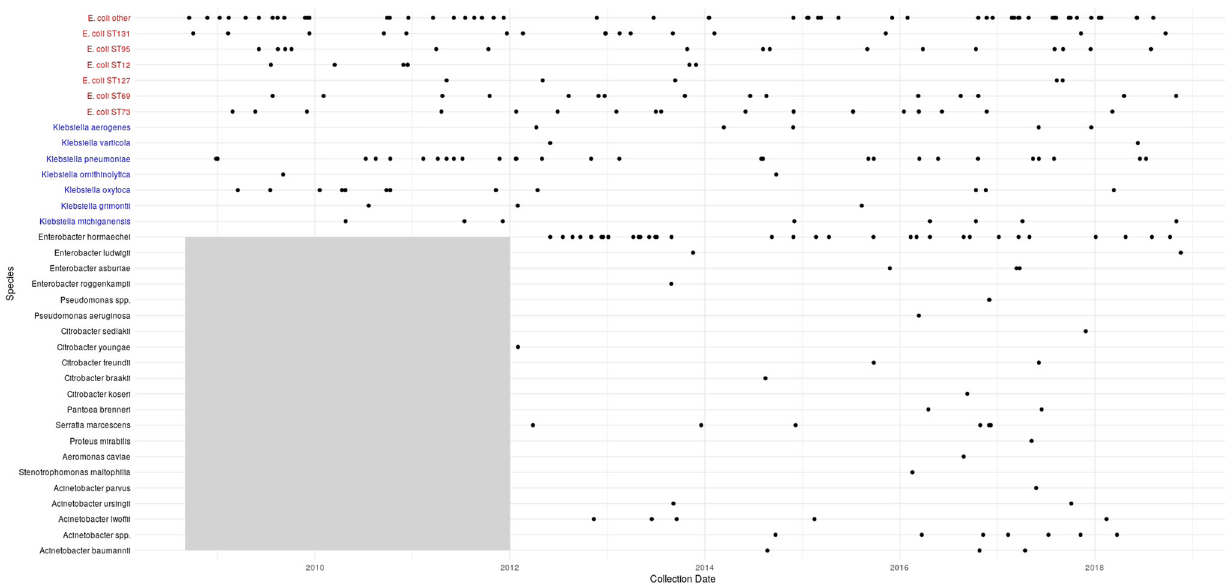
Fig. 2 Species (and sequence type, ST, where shown) for sequenced isolate over time. Each point represents the isolation date of a sequenced isolate. The grey shaded area represents the fact that sequencing of non- E. coli / Klebsiella spp. isolates did not begin prior to 2012.